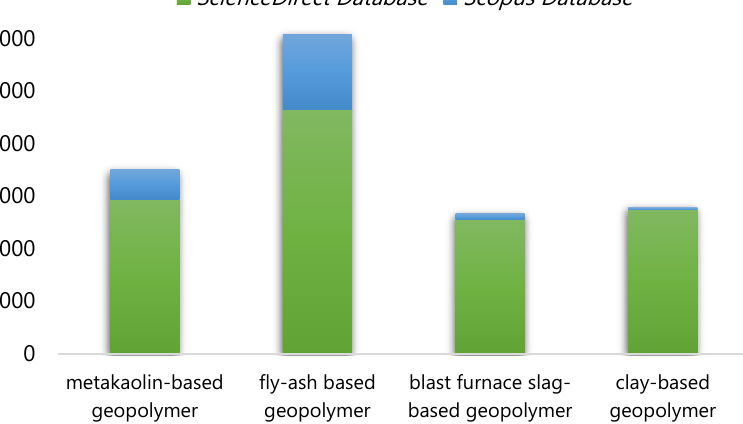
Figure 6. Number of articles vs. different precursors used in search phrase.